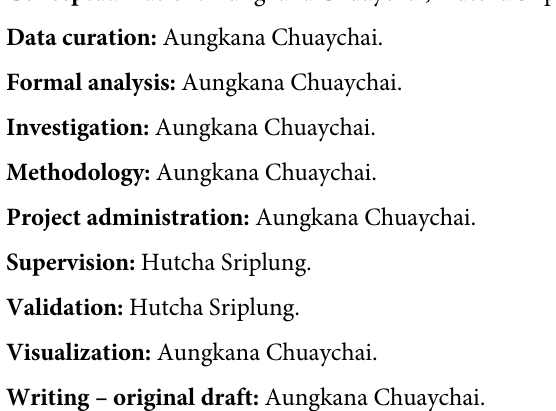
S1 Table. Demographics and tumor characteristics of observed data stratified by receptor status. S2 Table. Demographics and tumor characteristics stratified by receptor status after impu- tation of unknown receptor